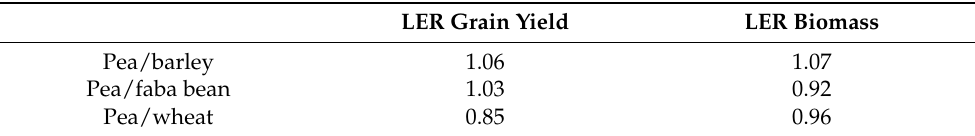
Table 4. Land equivalent ratio (LER) values for grain yield (trials Alm1-19(i) and Cord2-19(i)) and biomass (trials Alm1-19(i), Cord1-19(i) and Cord2-19(i)). No significant differences between any of them in each case were detected, and they did not significantly deviate from 1.